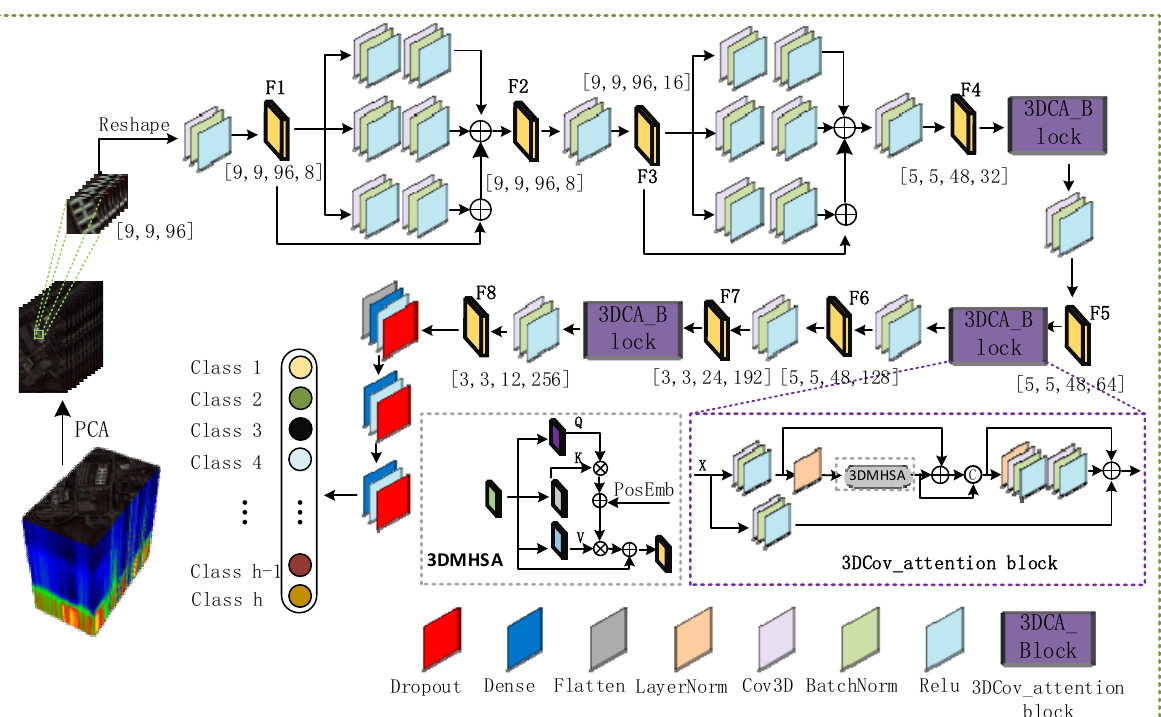
Figure 1. Proposed 3DSA-MFN network framework. The proposed method preprocesses the original data through dimensionality reduction and window clipping, then sends the processed data to multiscale feature fusion, 3DCOV_attention and other modules for feature extraction, and finally outputs the classification results over multiple fully connected layers.